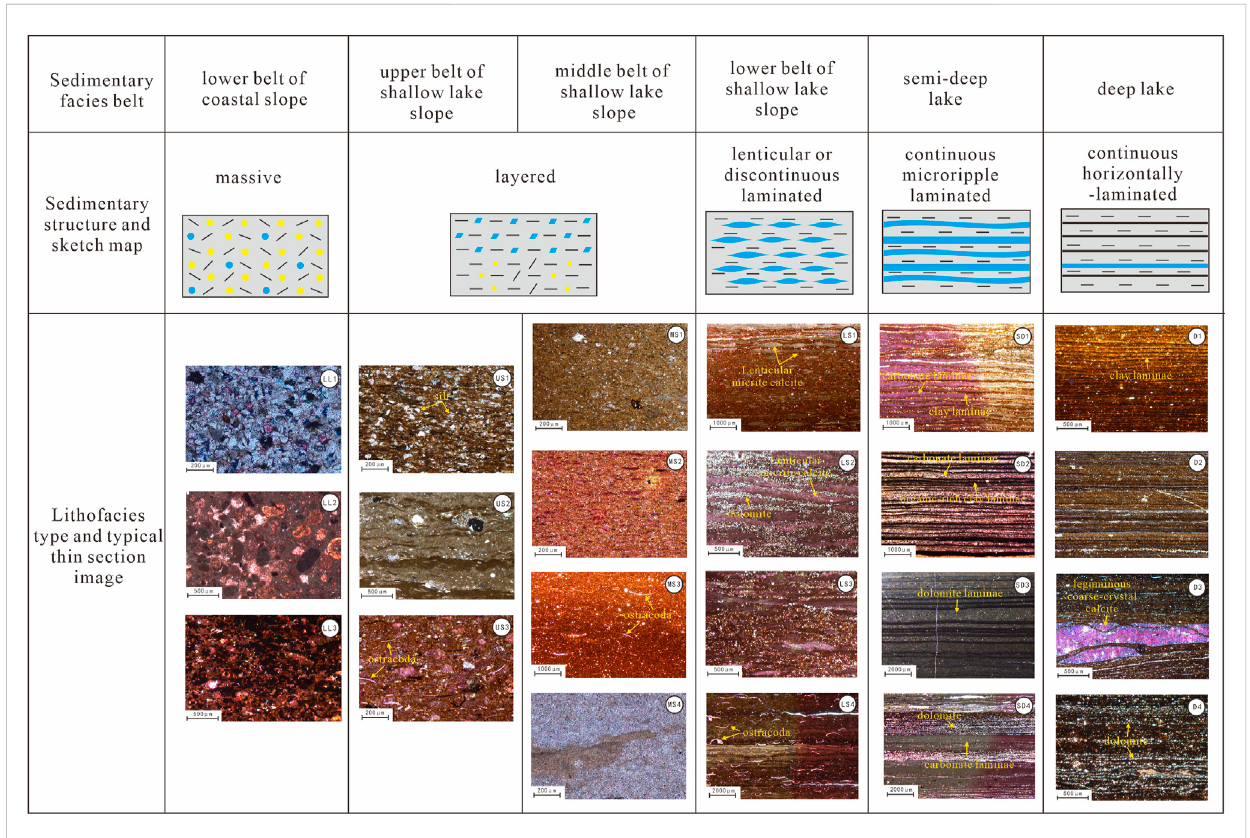
FIGURE 2 Lithofacies types of shale in the upper member of Es 4 of the Dongying